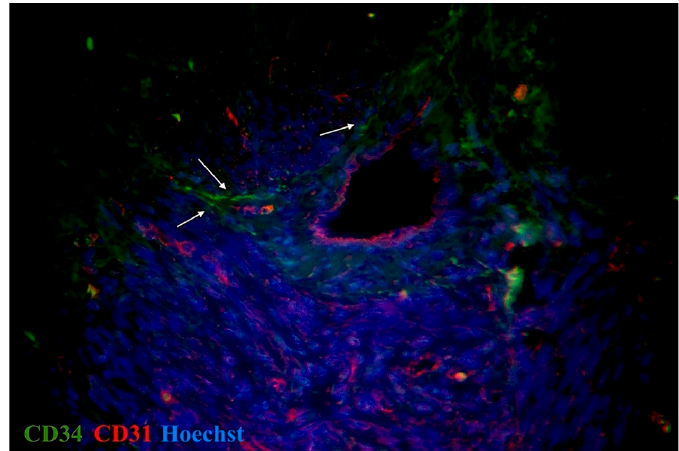
Figure 5. Double immunolabelling of human myometrium stained for CD31 (red, Alexa Fluor 594) and CD34 (green, Alexa Fluor 488) from control. Nuclei stained by Hoechst 33342. Doubly immunopositive cell with long cellular prolongation identified as telocytes (marked by arrows). Total magnification: × 400.